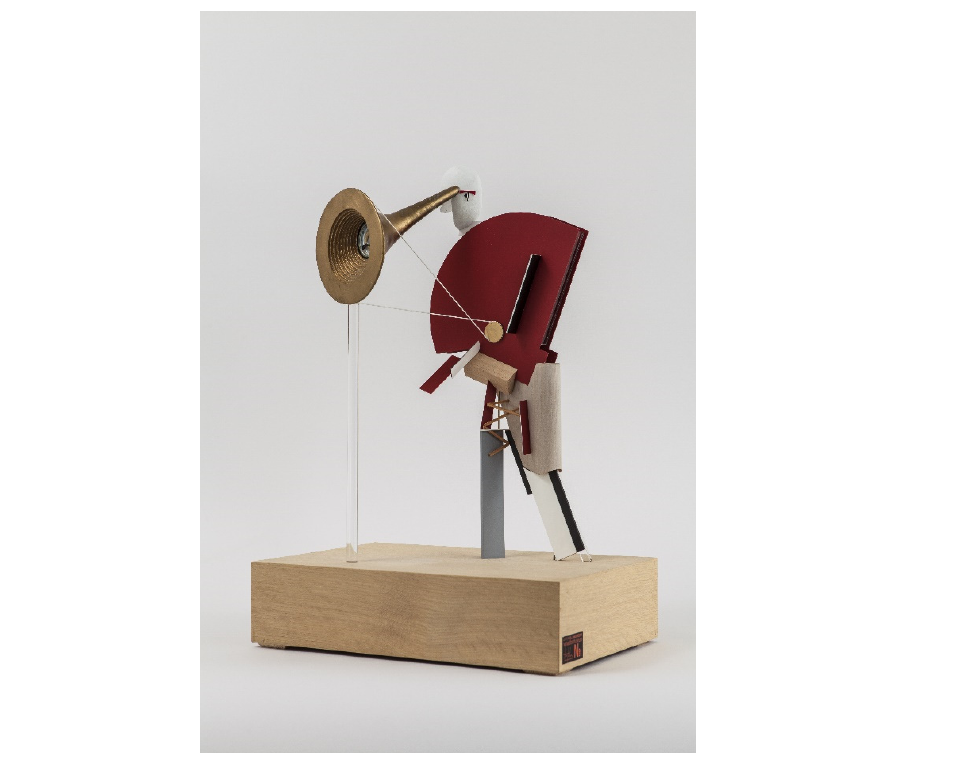
Figure 17. Model after El Lissitzky, ‘The Announcer’, 1923, construction by Henry Milner, 2009. Van Abbemuseum, photo Perry van Duijnhoven.